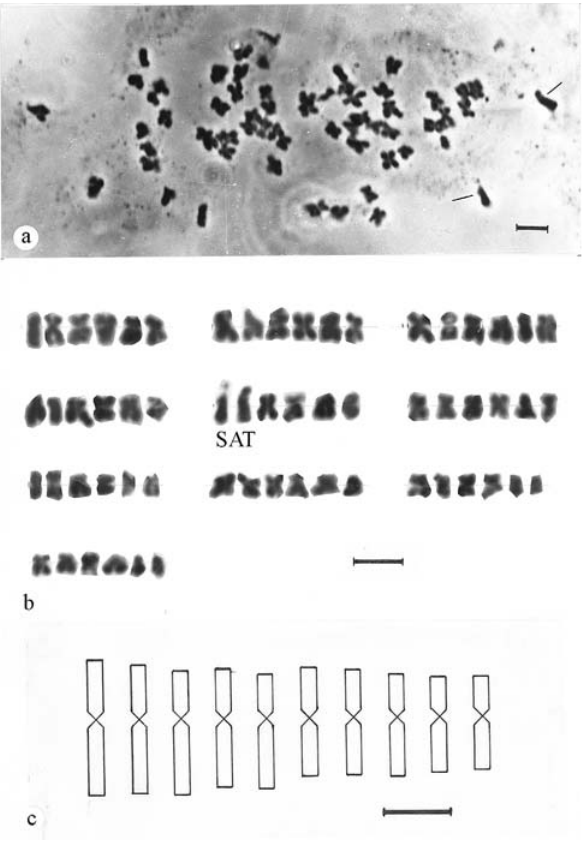
Figure 5 - Mitotic chromosomes in Eupatorium laevigatum . Key: a = Mi- totic metaphase showing 60 chromosomes; b = karyotype; c = ideogram. Bar represents 5 µ m (a, b) and 1 µ m